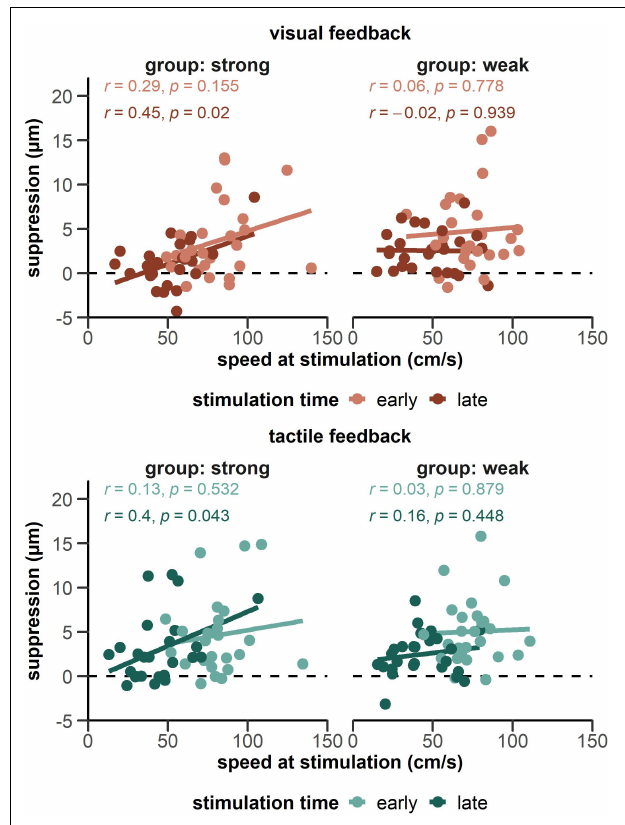
FIGURE 6 | Correlations between magnitude of the suppression effect and movement speed at the time of stimulation. Data is plotted separately for both groups receiving a strong tactile feedback (left side panels) and a weak tactile feedback (right side panels) , as well as visual and tactile feedback. With strong tactile feedback, both the visual- and tactile-late condition (darker lines on the left panels) showed a significant